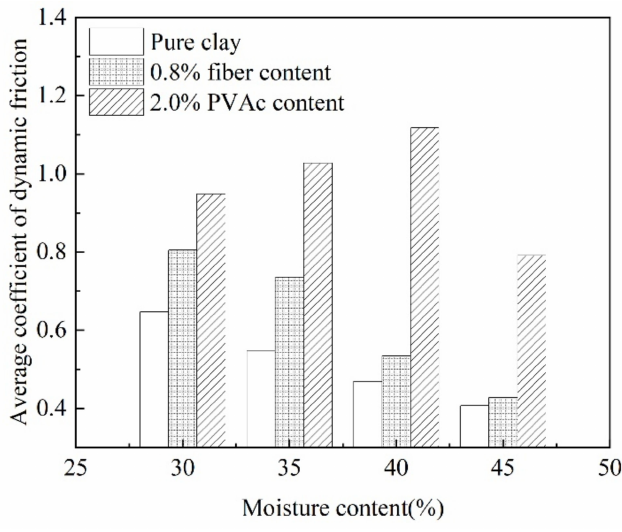
Figure 10. Average coefficient of dynamic